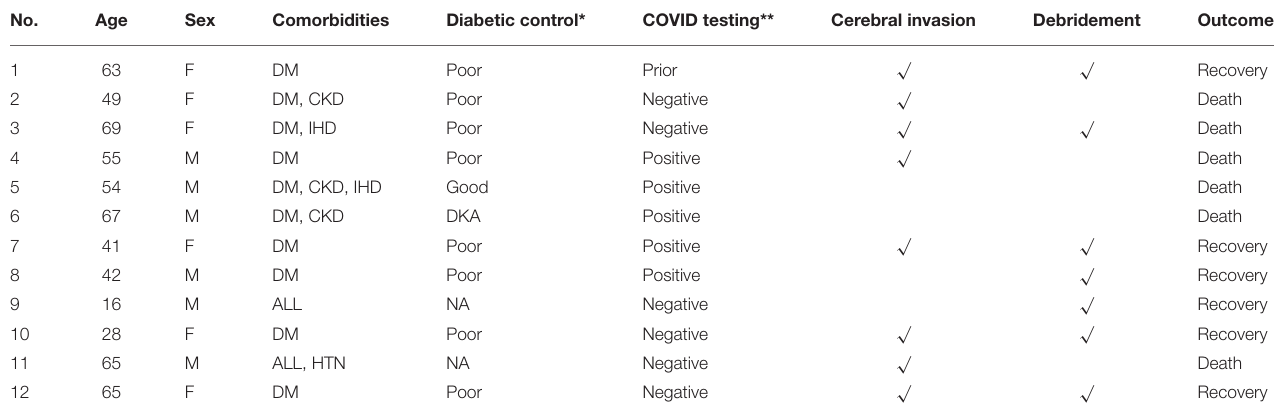
TABLE 1 | Demographic and clinical data of the 12 cases presenting with rhino-orbital-cerebral mucormycosis (ROCM).